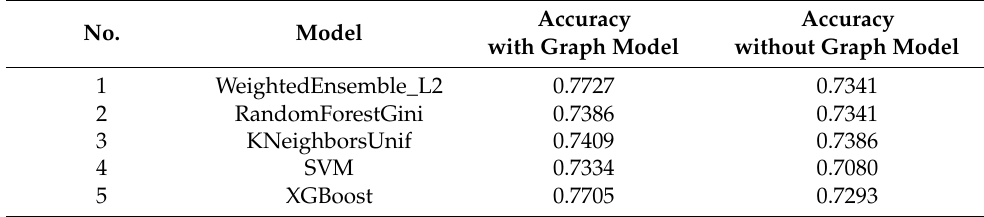
Table 4. Comparison of the diagnostic accuracy with and without the association graph model.